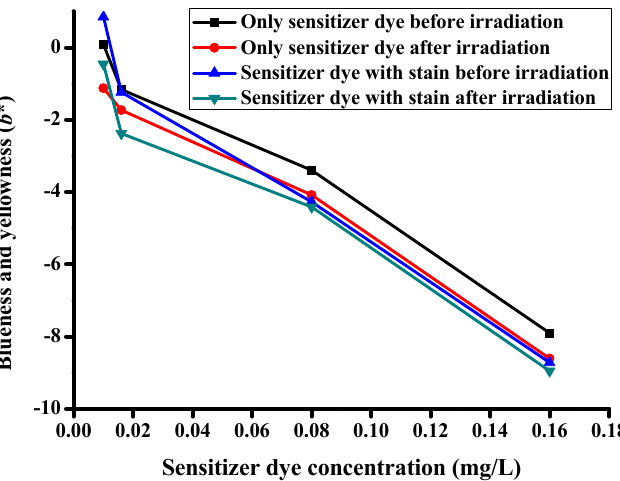
Figure 11. The b * values of dye/TiO 2 ‐ coated cotton fabrics.